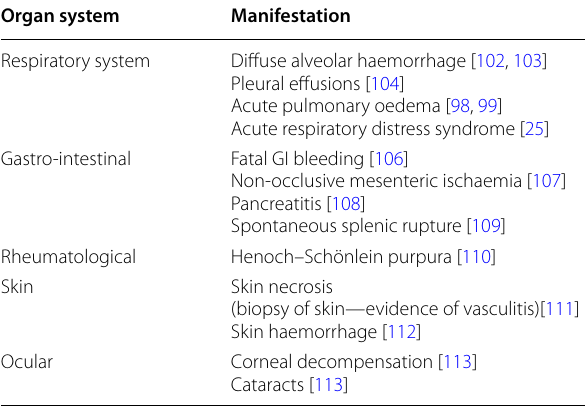
Table 3 Other organ system effects of wasp